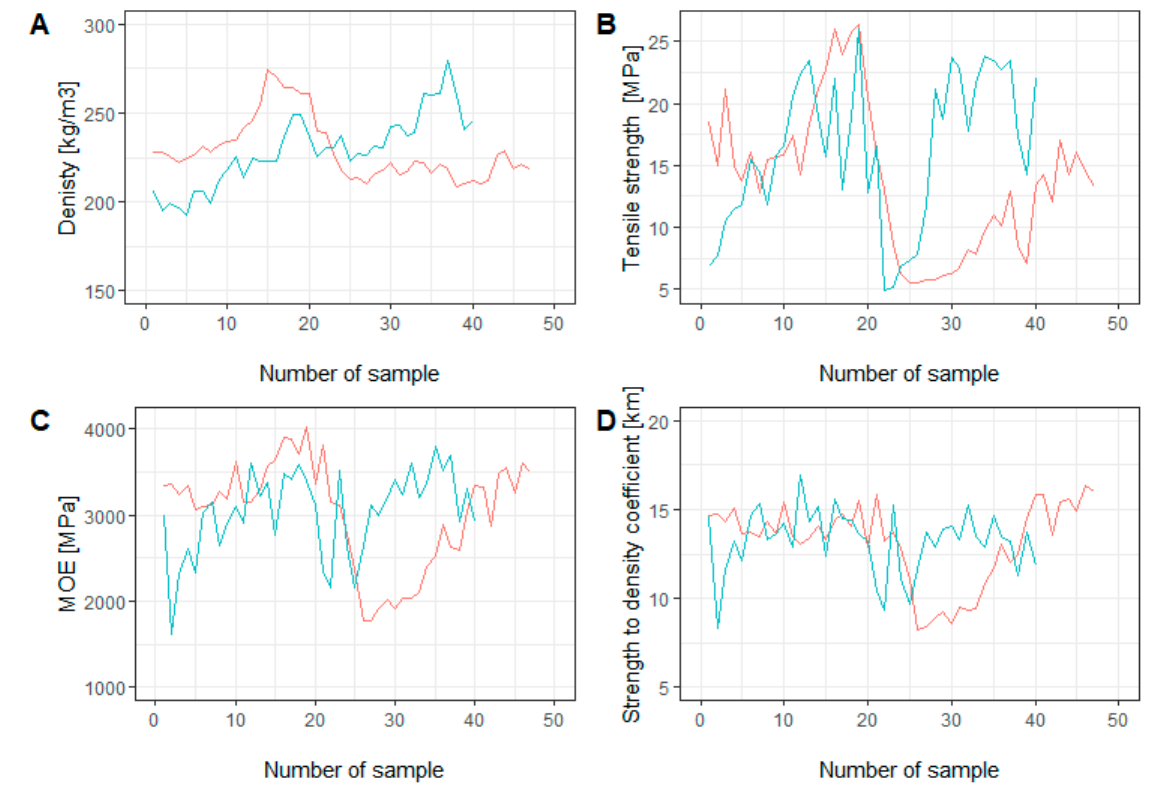
Figure 6. Cross-section comparison of examined properties collected at breast height: ( A ) density [kg/m 3 ]; ( B ) tensile strength [MPa]; ( C ) modulus of elasticity [MPa]; ( D ) strength-to-density coefficient [km]. Sample no. 0 is from the pith, no. 90 is at the bark. IC (red line): the first annual ring between samples 1 and sample 15 and the second annual ring between samples 16 and 47. IIIC (blue line): the first annual ring between samples 1 and sample 19 and the second annual ring between samples 20 and 40. Table 7. Pearson correlation of examined properties from the ground section: density, modulus of elasticity, tensile strength, and strength-to-density coefficient.